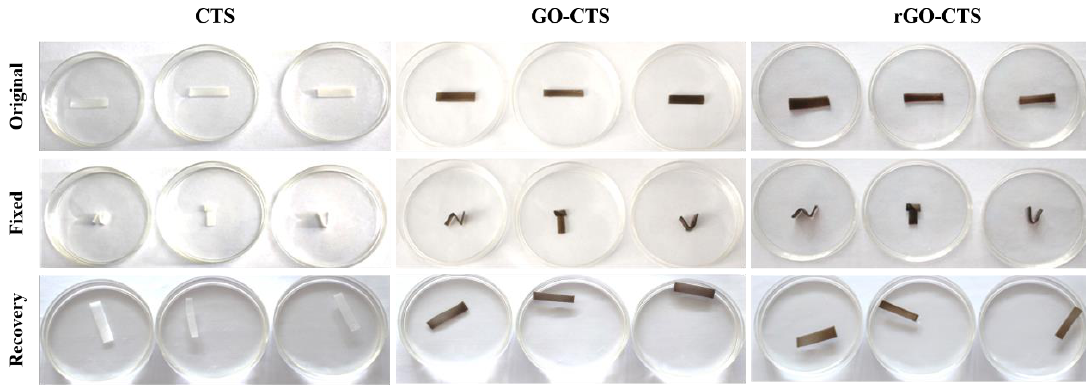
Figure 3. Shape-memory properties of the CTS, GO-CTS, and rGO-CTS cryogels.